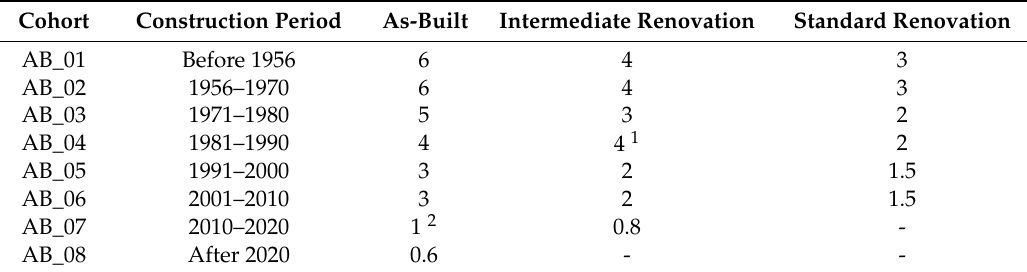
Table 3. Chosen infiltration rates in air changes per hour (ACH) at 50 Pa for the different age classes and energy standards. Cohort Construction Period As-Built Intermediate Renovation Standard Renovation Before